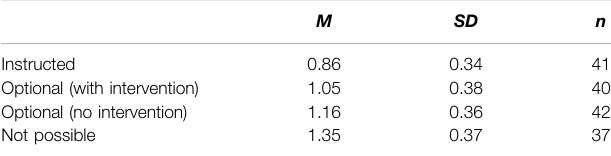
TABLE 2 | Means and standard deviations for accuracy scores (absolute mean difference score between predicted and actual attitudes) in Study 3. M SD n Instructed